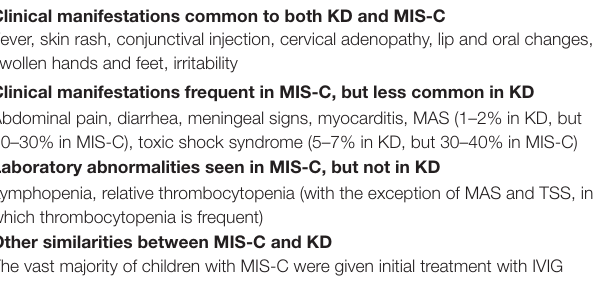
TABLE 1 | Main similarities and differences between MIS-C and KD. Clinical manifestations common to both KD and MIS-C Fever, skin rash, conjunctival injection, cervical adenopathy, lip and oral changes, swollen hands and feet,